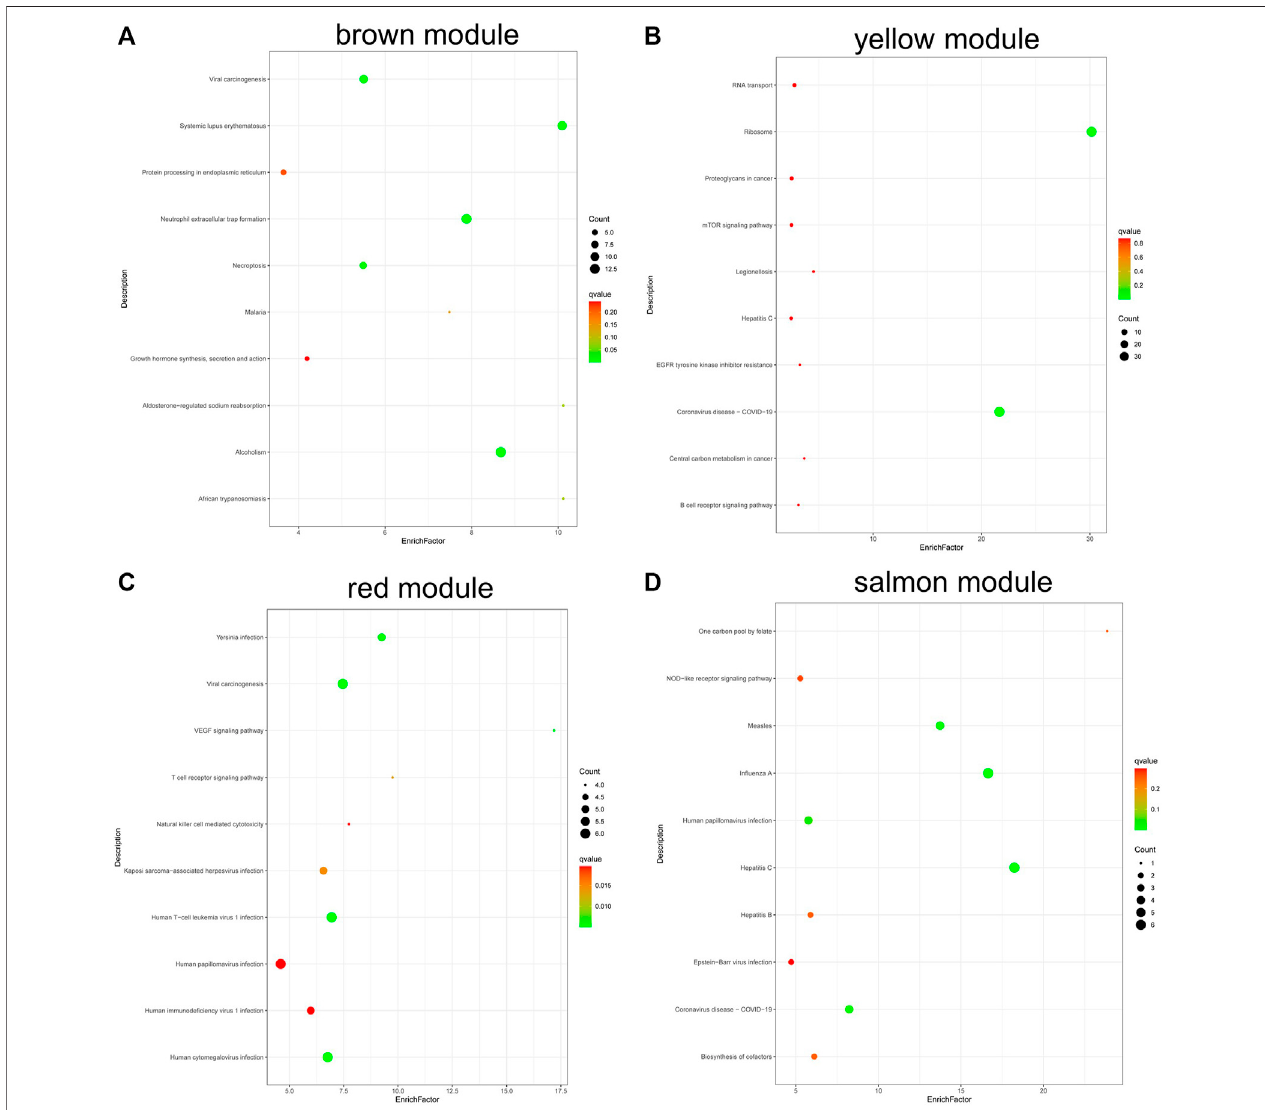
FIGURE 8 | KEGG pathway analysis of genes in coexpression modules associated with relapsed GD. (A) Brown module; (B) Yellow module; (C) Red module; (D) Salmon module.